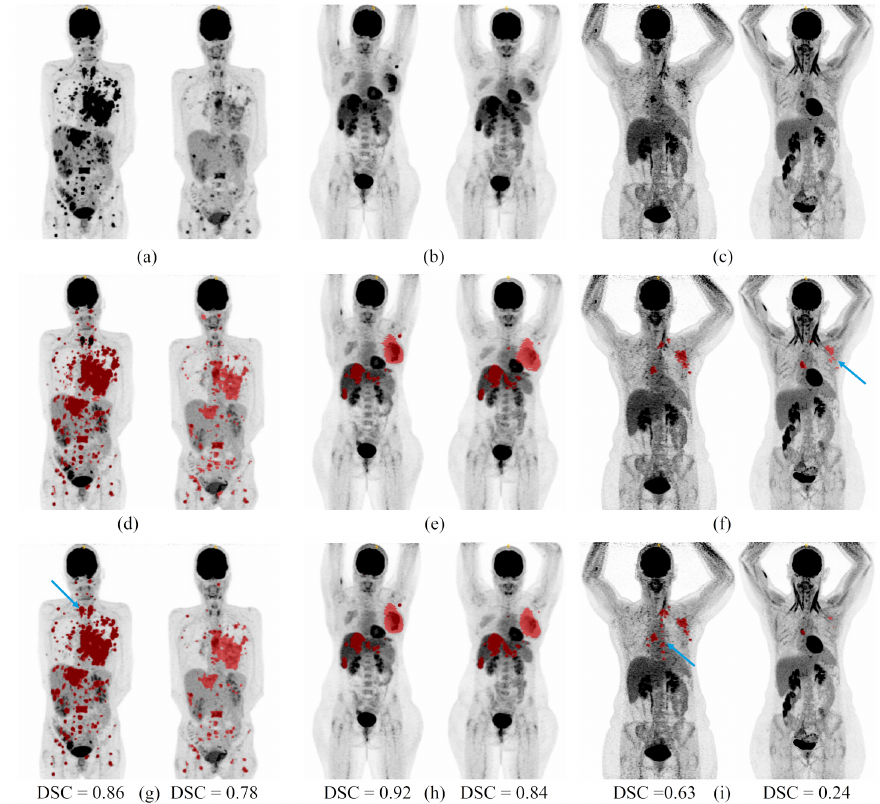
Figure 3. Segmentation examples on two acquisitions from 3 patients from the test dataset. ( a – c ): Max- imum intensity projections of PET images. ( d – f ): Ground truth segmentation overlaid on the maxi- mum intensity projections of PET images. ( g – i ): Automatic segmentation overlaid on the maximum intensity projections of PET images. U-Net BL was used on the baseline acquisition and U-Net FU on the follow-up acquisitions. For each pair of images: on the left the baseline acquisition and on the right the follow-up acquisition. DSC = dice score between the ground truth and the automatic segmentation. Blue arrows outline discrepancies between manual and automatic